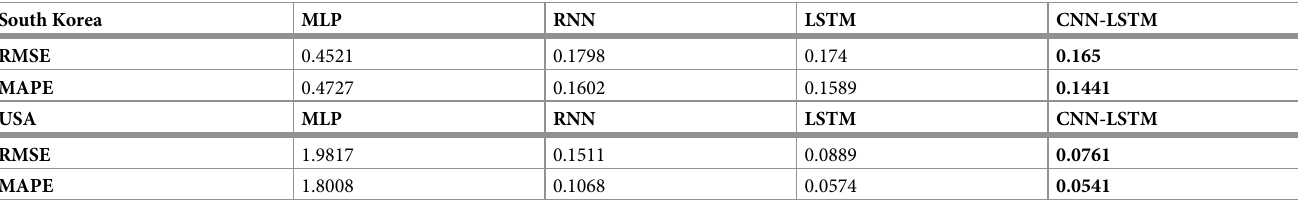
Table 3. Forecasting performance